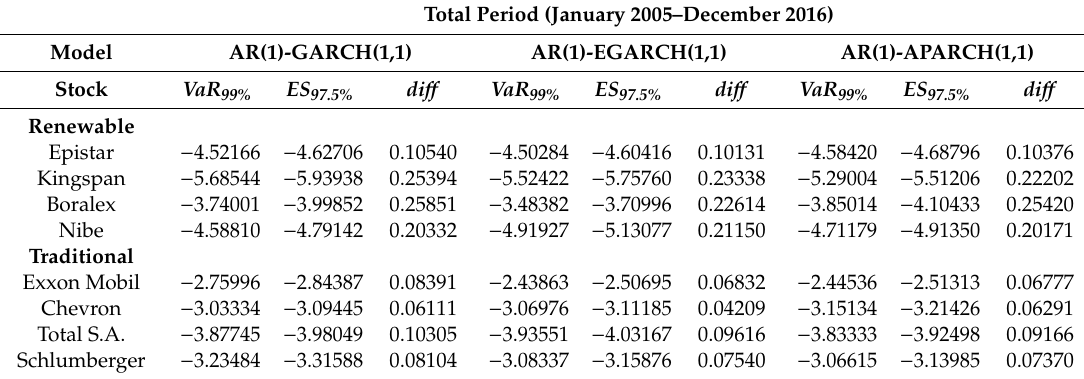
Table 6. Capital requirements percentage for energy stocks under skewed-t